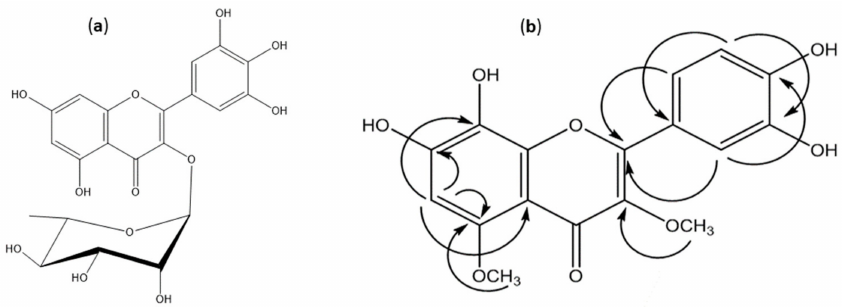
Figure 1. ( a ) Structure of compound 1 . ( b ) HMBC correlations of compound 7,8,3 (cid:48) ,4 (cid:48) -tetrahydroxy-3,5- dimethoxyflavone ( 2